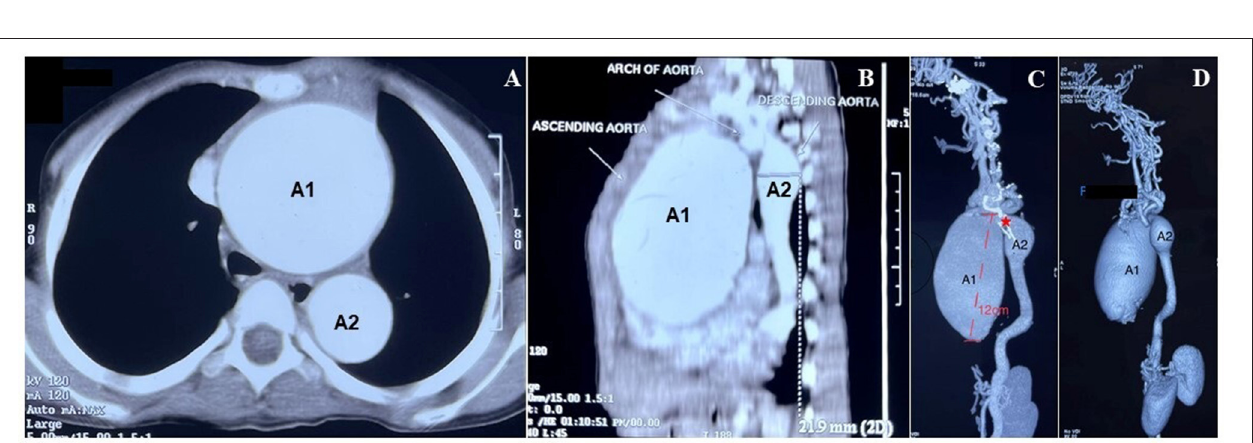
FIGURE 2 | Diagnosis of two fusiform aortic aneurysms. (A) Computerized tomography (CT) aortogram section (axial view) below the level of the aortic arch showed marked dilatation of the ascending (A1) and the descending (A2) aorta (scale 1:5). (B) CT aortogram shows the sagittal view of the dilated aneurysms as described in (A) . (C) Reconstructed maximum intensity projection images of a contrast-enhanced CT showed 2 fusiform aneurysms. The larger aneurysm (A1) ranges for a length of about 12cm, involving the ascending aorta and extending to proximal arch along with root involvement. The smaller (A2) aneurysm was noted extending from the distal arch to the proximal descending aorta (scale 1:5). The prominent “sausage link appearance” (*), can be appreciated between the 2 aneurysms. The rest of the descending aorta showed a tortuous course, atypical for the age of the patient. (D) CT images (3D volume rendered) show the aneurysms as described in (B)